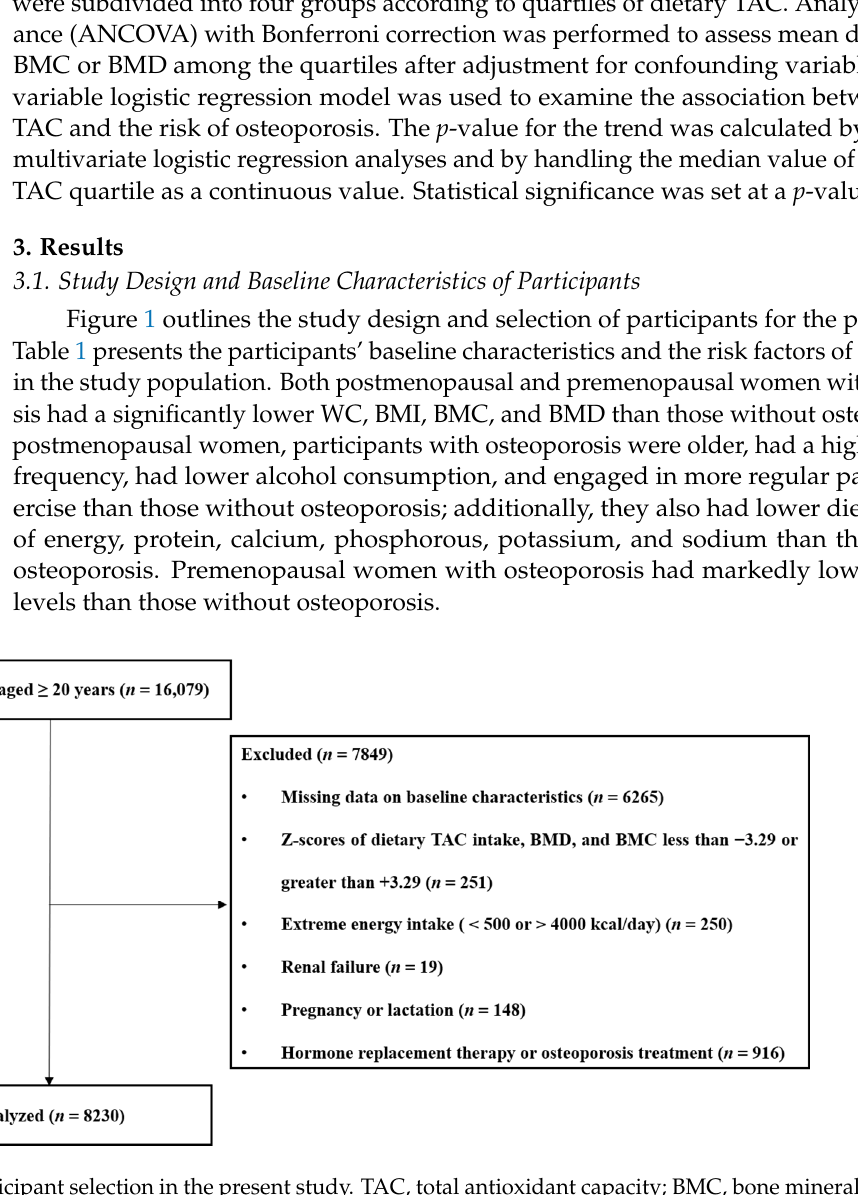
Figure 1. Summary of participant selection in the present study. TAC, total antioxidant capacity; BMC, bone mineral content; BMD, bone mineral